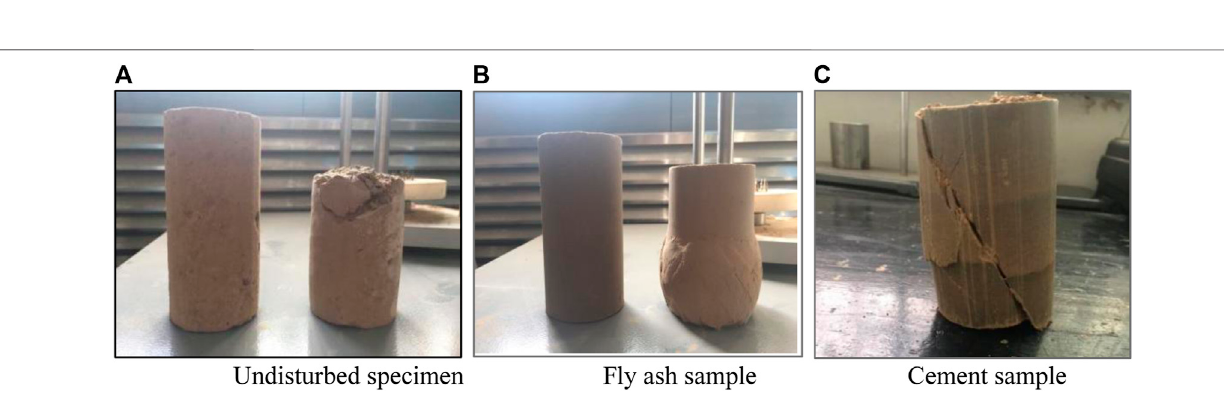
Frontiers in Earth Science |